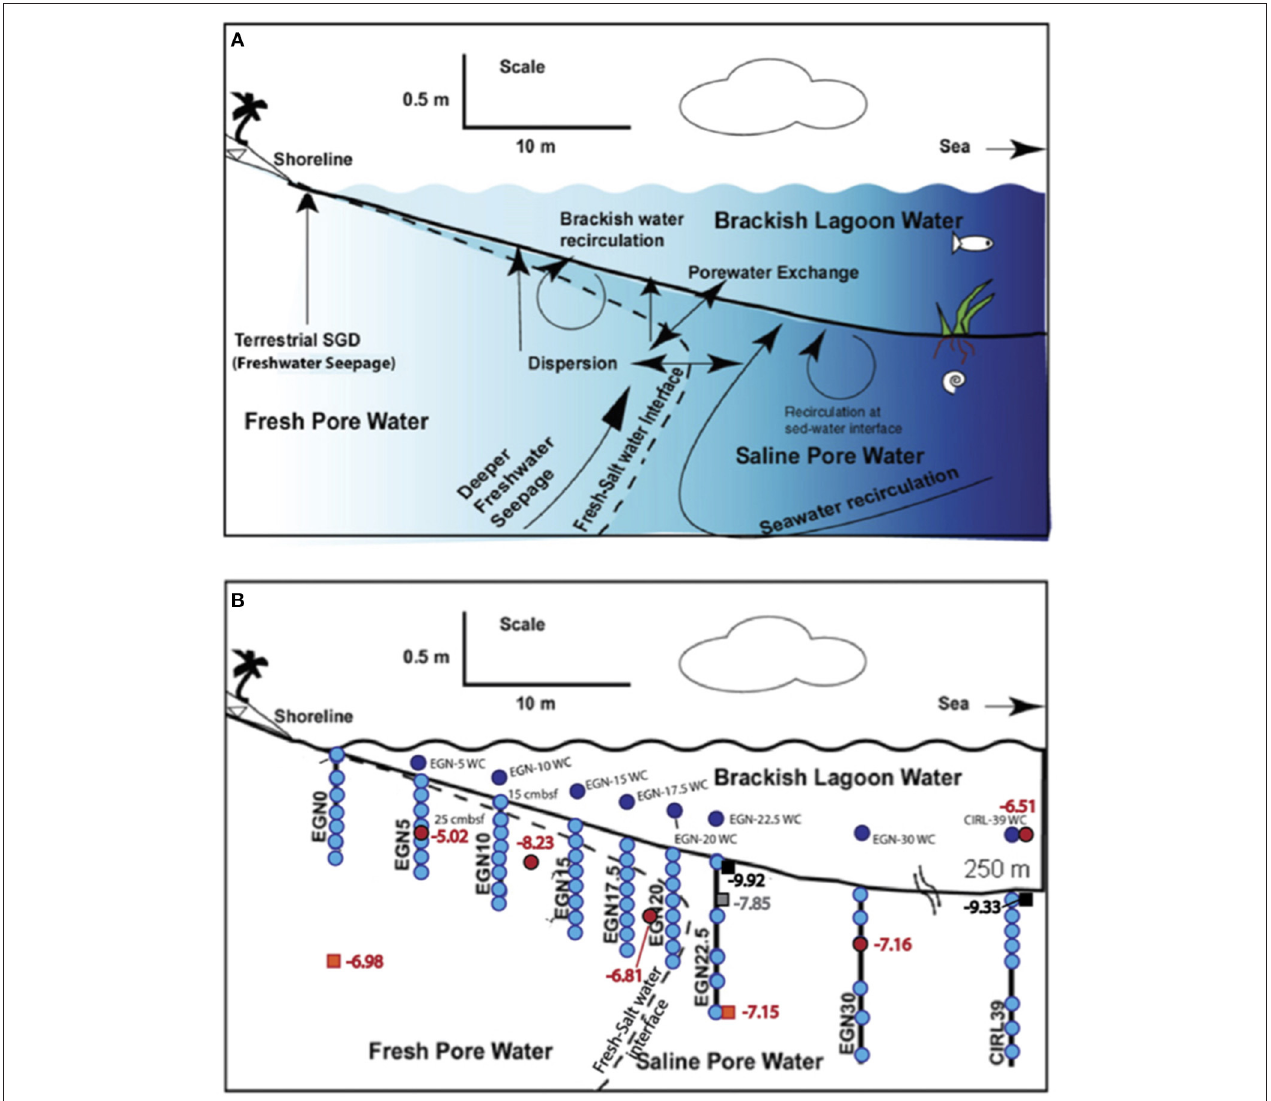
FIGURE 2 | Highly schematic cross-section through the nearshore transect (i.e., EGN – x) portion of the Indian River Lagoon subterranean estuary. (A) Shows hypothetical flow paths for SGD in the subterranean estuary underlying the Indian River Lagoon. Note, “sed-water interface” is the sediment-water interface. (B) Illustrates the approximate locations of the multisamplers along the nearshore transect where groundwater was collected for REE analysis (light blue circles; Chevis et al., 2015b) and Nd isotope analysis (red circles, this study). Dark blue circles show the location of surface water samples analyzed for REEs (Chevis et al., 2015b). Orange squares, gray square, and black squares show location of sediment samples analyzed for Nd isotope compositions color coded orange for the Fe production zone, gray where Fe is re-adsorbed in the Fe sink zone, and black where Fe-sulfide minerals (e.g., mackinawite) precipitate in the Fe sink zone (see Roy et al., 2010, 2011). Numbers adjacent to each symbol for the sediments represent measured ε Nd (0) values. Cross-section is modified after Martin et al. (2007), Cable et al. (2007), and Roy et al.